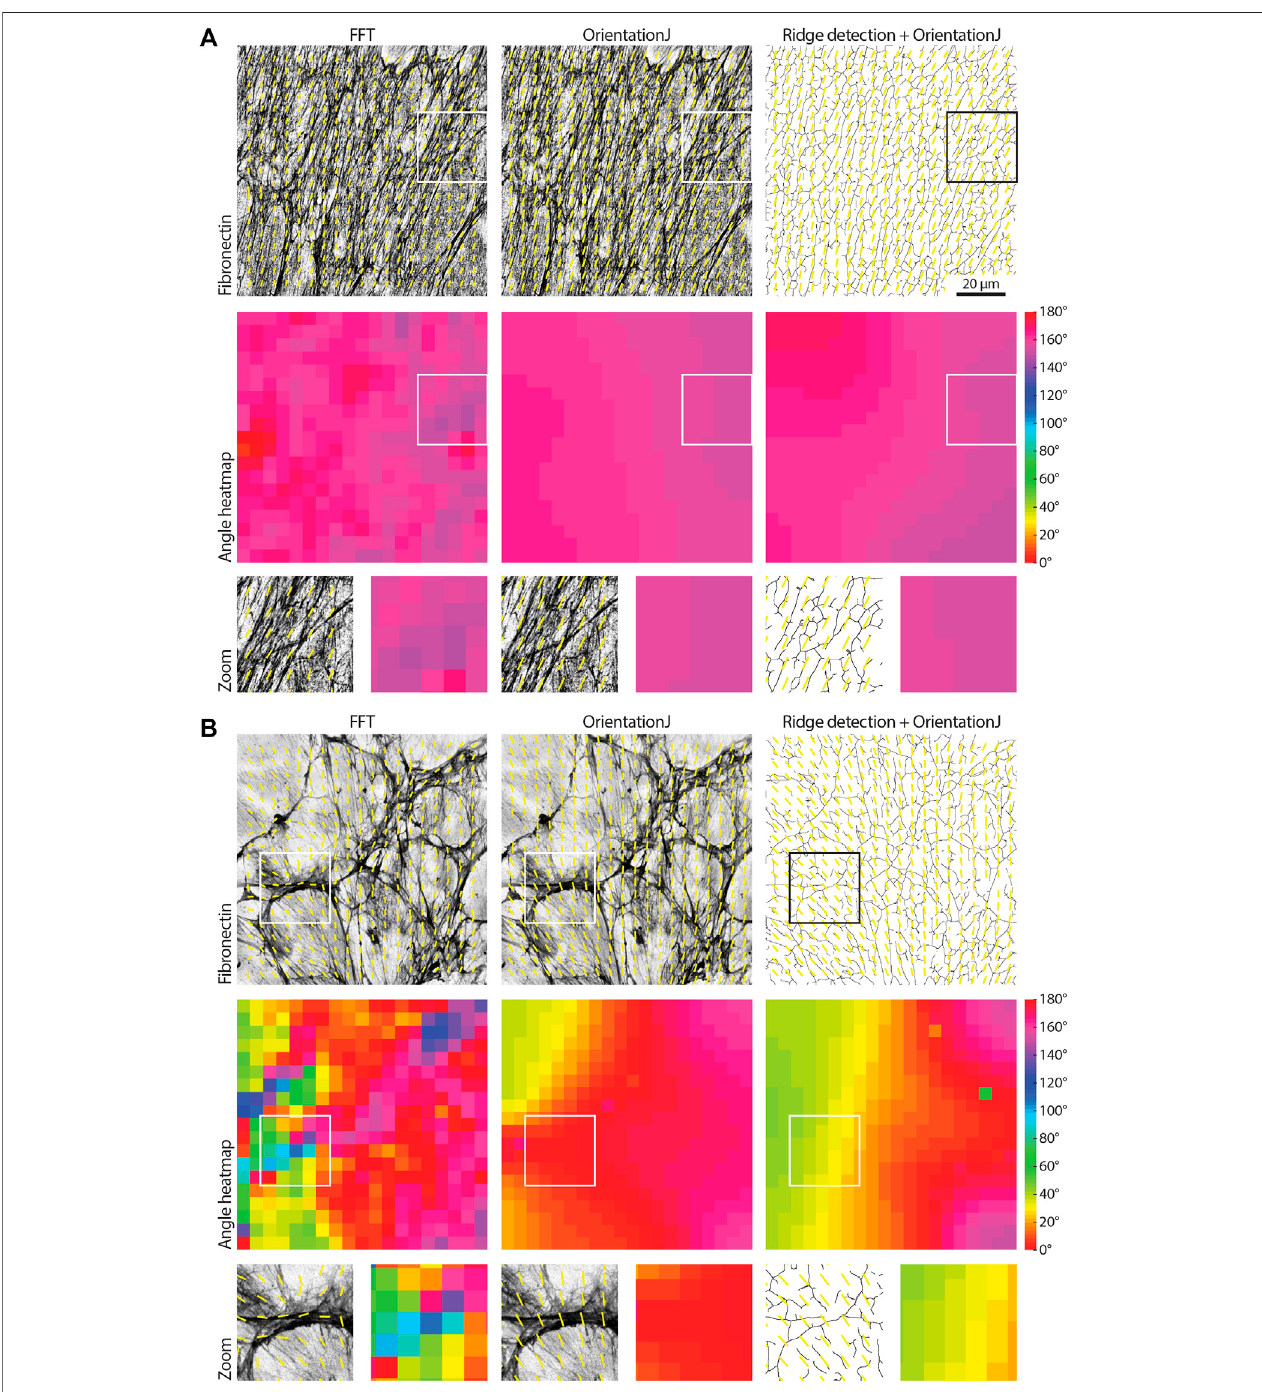
FIGURE 9 | Comparing approaches to measure organization in biological images. (A) A fi bronectin image showing fi brillar features with strong alignment is analyzedwiththe FFT approach presented in this work, with theFijiOrientationJ Vector Field plugin, and with acombinedapproach using the FijiRidge Detection plugin followed by OrientationJ (mimicking the TWOMBLI hybrid approach, the binary mask calculated by the Ridge Detection is shown). A window size of 100 px with 50 % overlap was used, and the order parameter was calculated over neighborhoods of 5 x vectors (neighborhood radius of 2 x vectors). Both the alignment vector fi eld and the angle heatmap are shown for each case; zooms for the areas highlighted by the white boxes are displayed. The three algorithms behave similarly. Scale bar, 20 μ m . (B) The analysisof amore randomly organized fi bronectin image iscompared as in (A) .It can benoted how the FFTreturns more accurate alignment vectors for the more isotropic regions of the image